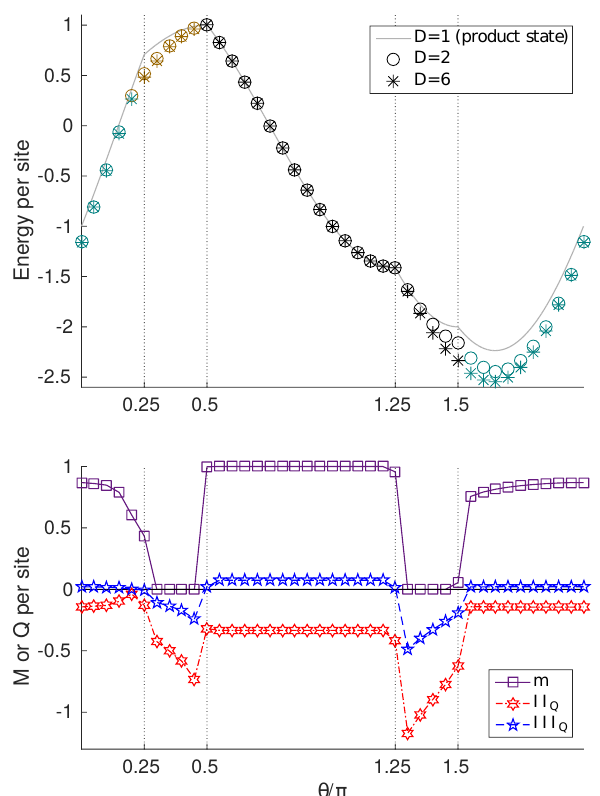
Figure 7: Top : energy per site for D = 1,2,6 simple update simulations using 2x2 and 3x3 unit cells; for each value of θ only the lowest (in energy) of the two is shown. The black markers correspond to a 1x1 unit cell state (energies for 2x2 and 3x3 simulations coincide). Bottom : magnetization per site m and the I I and I I I tensor invariants of the Q -matrix per site for Q Q the D = 6 simulations. I is identically zero (not Q